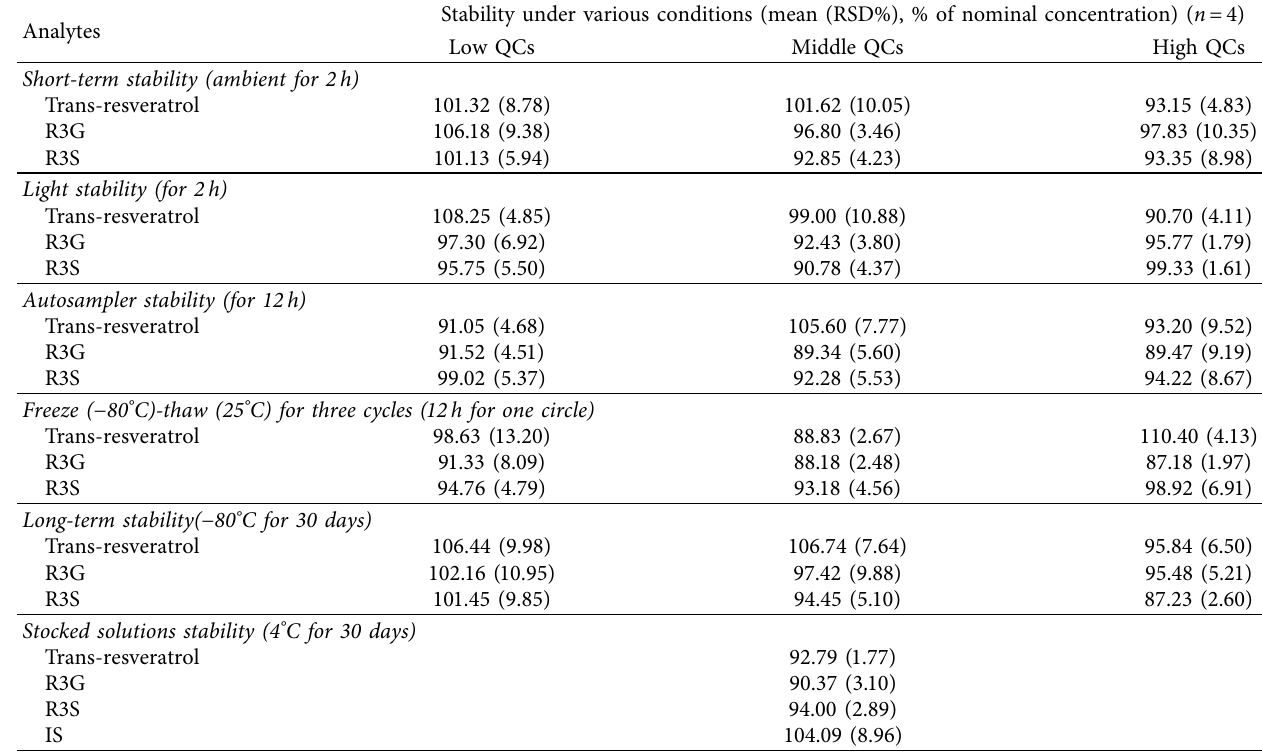
Table 4: Stability of trans-resveratrol, R3G, R3S, and IS under several conditions. Analytes